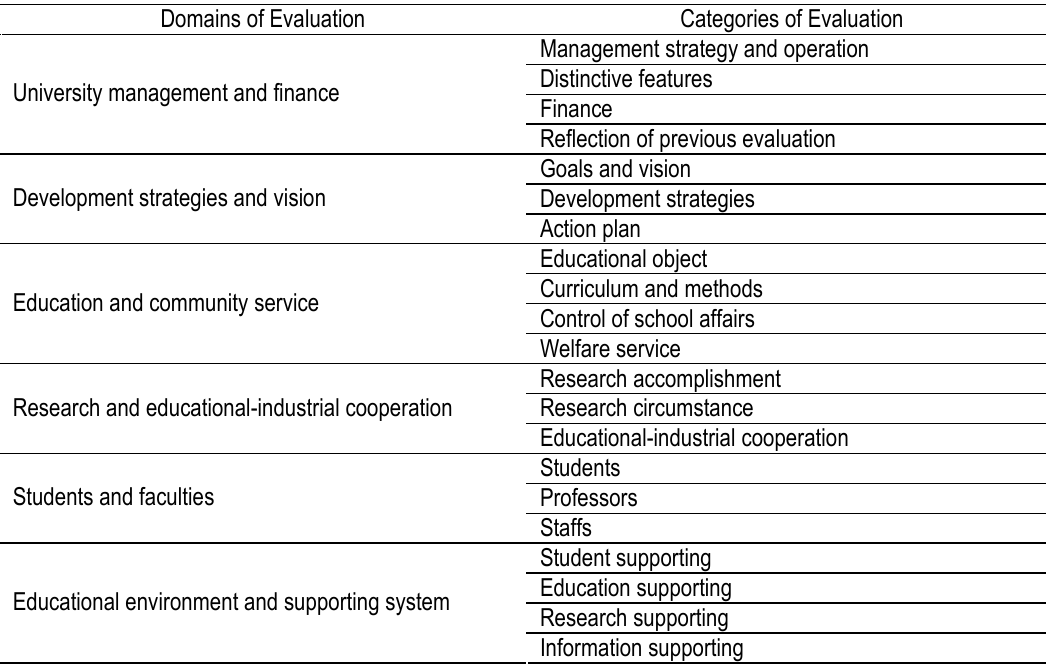
Table 1. Domains and categories of evaluation